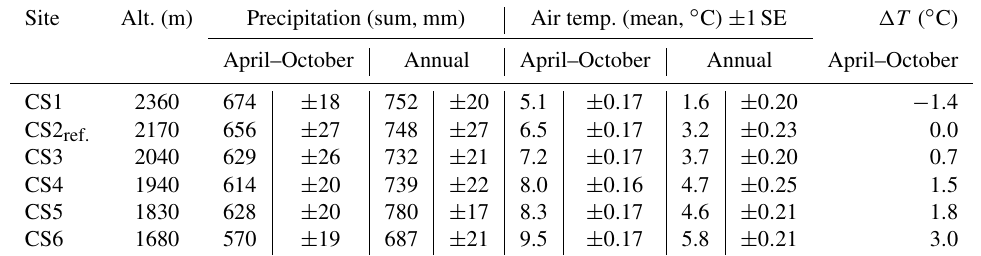
Table 1. Climate parameters at the climate scenario sites (CSs) between 2012 and 2017. Precipitation sums for climate scenario sites, aggregated from April to October and annually. Mean air temperature from April to October and for the whole year. Air temperature difference ( (cid:49)T ) April–October for respective CSs compared to CS2 reference (CS2 ref .